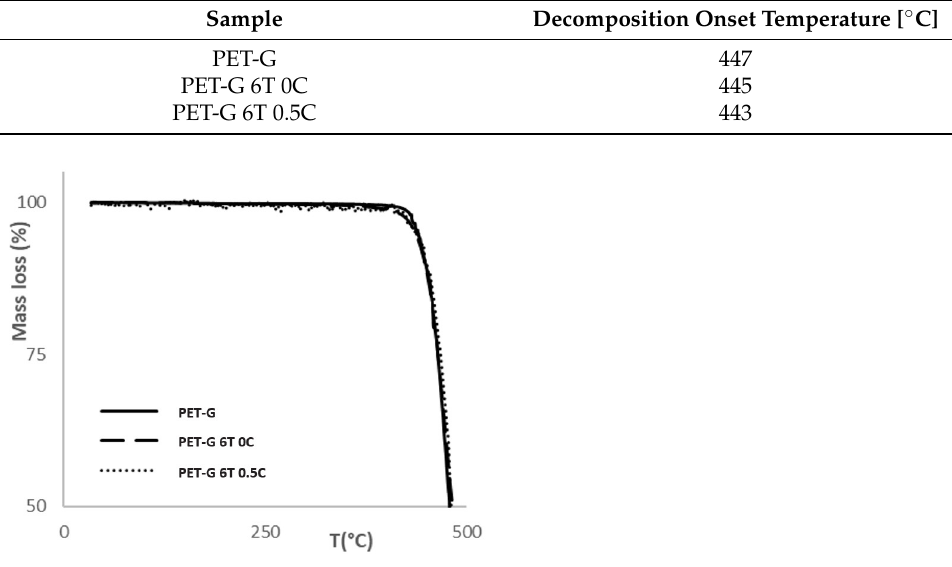
Figure 6. Graphical representation of TGA test results of PET-G and composite samples . Table 5. TGA test results of PET-G and composite samples .